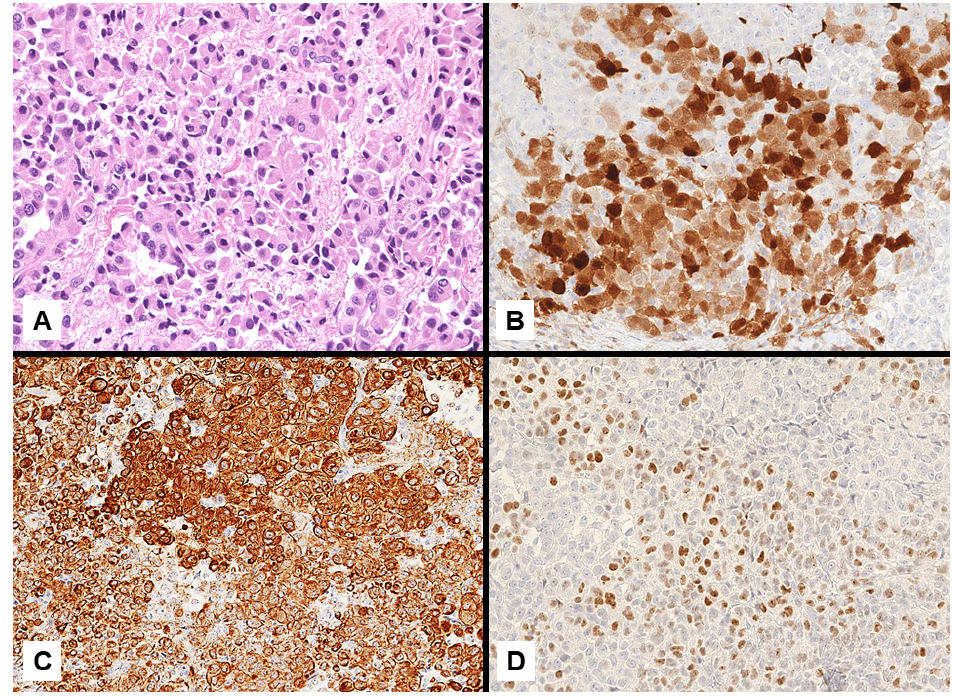
Figure 12. Epithelioid malignant mesothelioma ( A ) consistently staining calretinin ( B ) and CK5/6 ( C ), but unconventionally displaying nuclear expression of CDX2 ( D ).